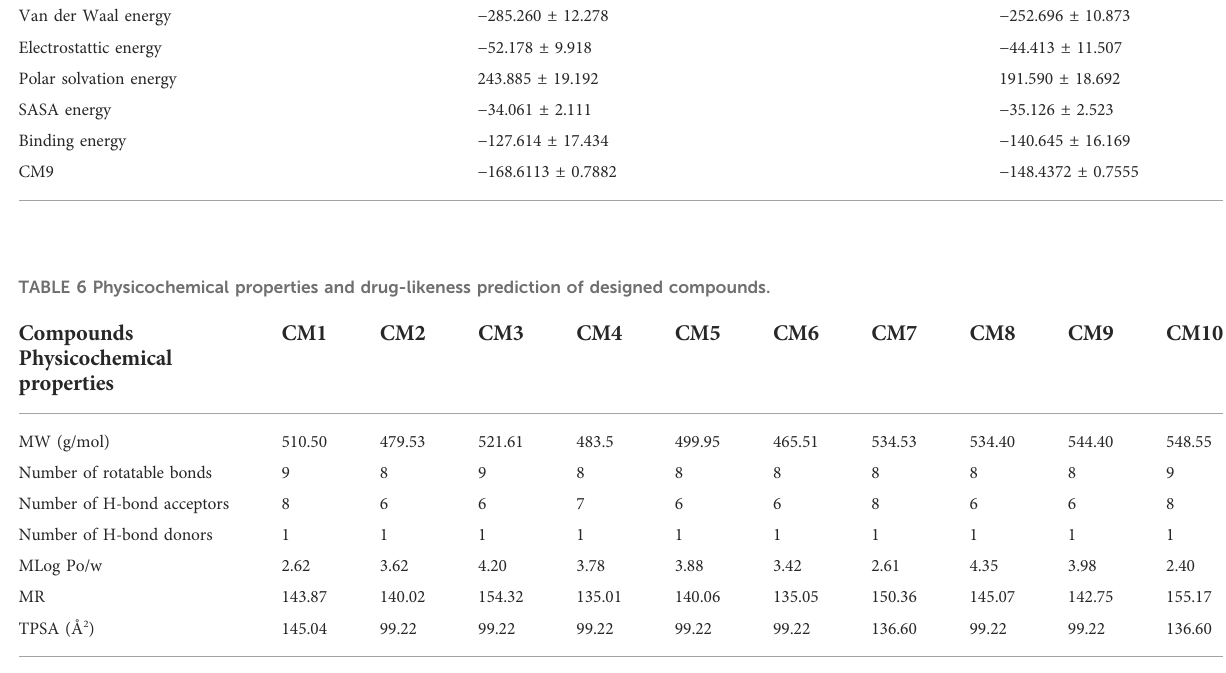
TABLE5Thebindingenergy andenergycontributionofligand CM9insidethe activesiteofMETandFLT4obtainedfromMMPBSAanalysis inkJ/mol. Energy (MET) (kJ/mol) Van der Waal energy